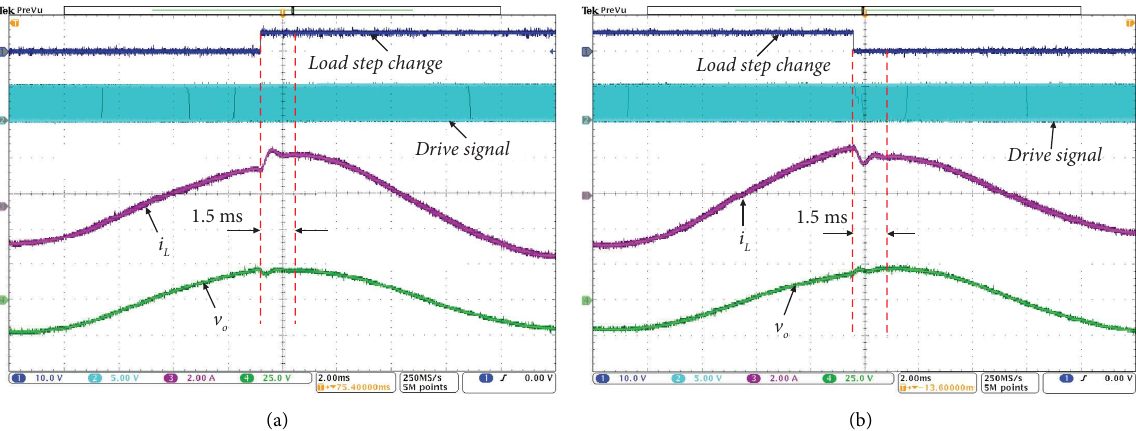
Figure 15: Transient waveforms with the PI controller at π /3. (a) Step change of i 3.5 A to 2.2 A.